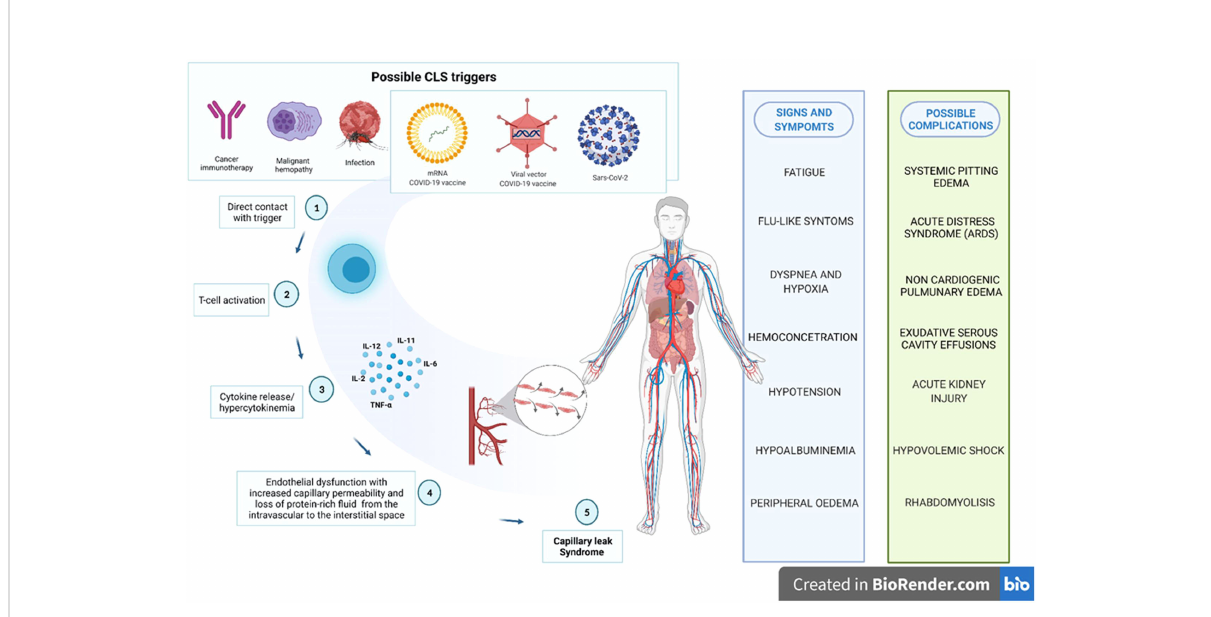
FIGURE 4 Possible biological plausibility of capillary leak syndrome induced by several triggers, including COVID-19